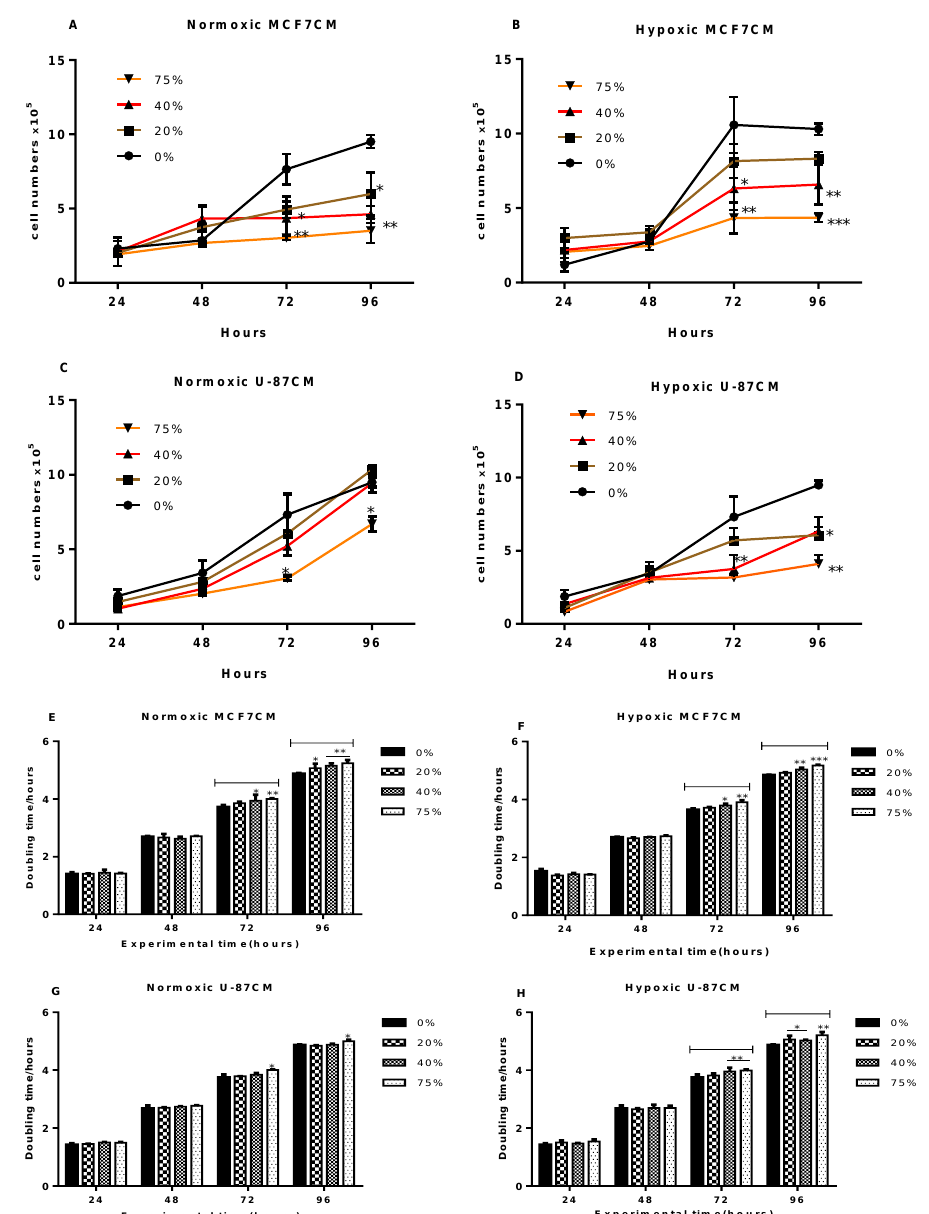
Figure 1. Shows the proliferation of bEnd.3 cells that were exposed to conditioned media produced from MCF7 and U-87 cells cultivated under normoxic (21% O 2 ) and hypoxic (5% O 2 ) conditions: ( A ) illustrates the proliferation rate of bEnd.3 cells after daily exposure to selected concentrations of normoxic MCF7CM (derived from breast cancer cells). ( B ) Shows the proliferation rate of bEnd.3 cells after daily exposure to selected concentrations of hypoxic MCF7CN. ( C ) Shows the proliferation rate of bEnd.3 cells exposed daily to selected concentrations of glioblastoma U-87 cell normoxically derived conditioned media (U-87CM). ( D ) Shows the proliferation rate of bEnd.3 cells daily exposed to selected concentrations of hypoxic U-87CM. ( E – H ) show the doubling time for bEnd.3 cells exposed to normoxic and hypoxic cancer secretions. (* p < 0.05, ** p < 0.01, *** p < 0.001; n = 3).